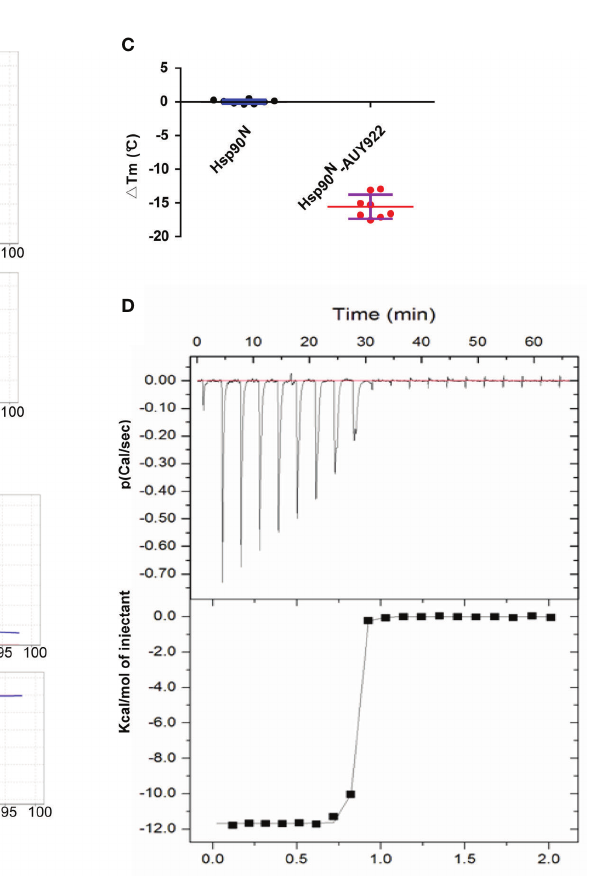
TABLE 1 | Dissociation constant and thermodynamic data for the target Hsp90 N binding with its ligand NVP-AUY922 at 25°C.